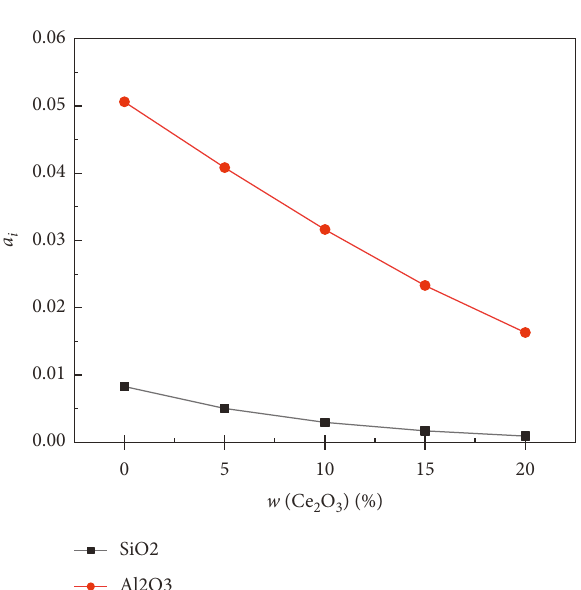
Figure 2: Influence of (w) (Ce 2 O 3 ) on the activity of Al 2 O 3 and SiO 2